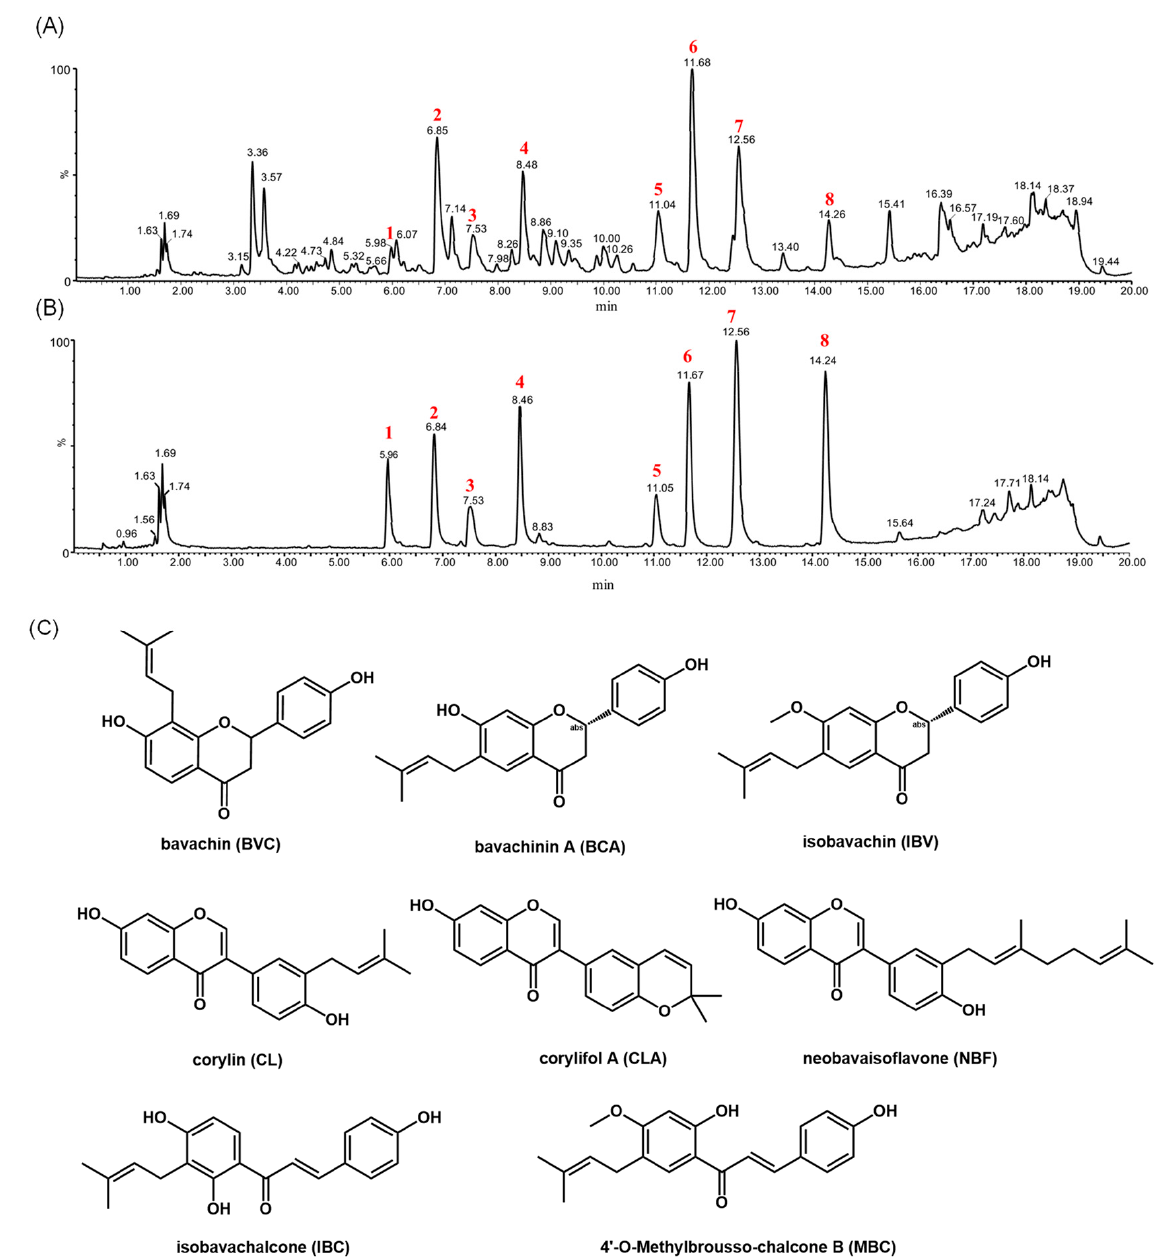
Figure 2. UPLC-MS/MS chromatogram of ( A ) Fr. A and ( B ) the references of compounds 1 – 8 in CPSs. ( C ) The chemical structure compounds 1 – 8 in Fr. A.